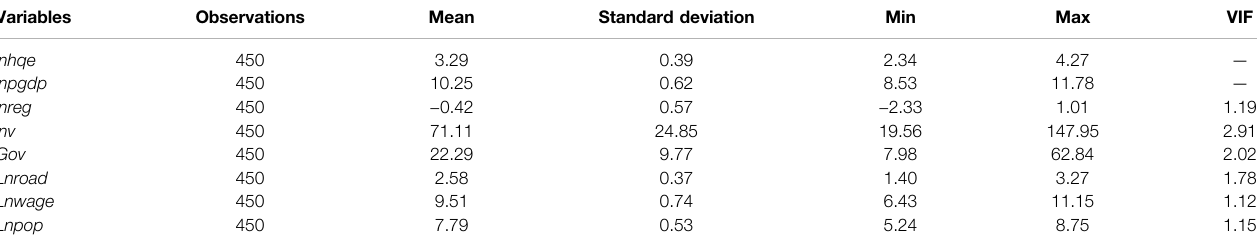
TABLE 4 | Descriptive statistics.